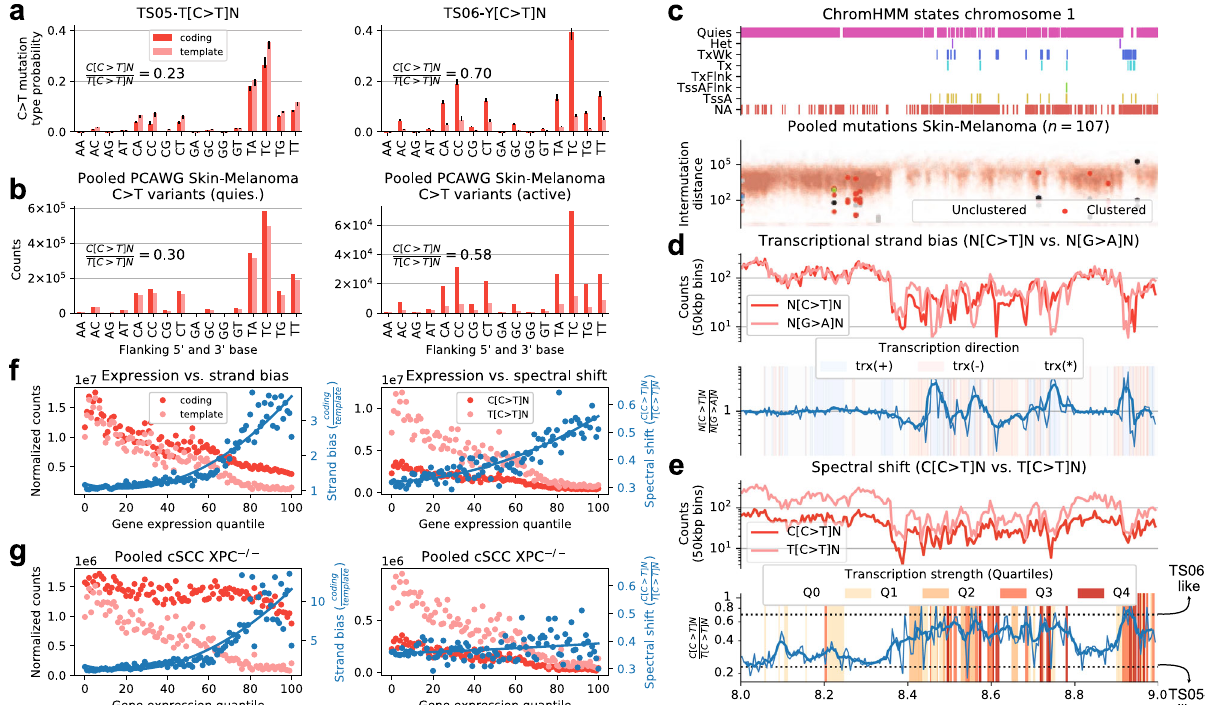
Fig. 4 The spectrum of UV mutagenesis changes from open to closed chromatin. a C > T mutation probabilities of TensorSignatures TS05 and TS06 for coding and template strand DNA (error bars determine 95% bootstrap con fi dence intervals). b Pooled PCAWG Skin-Melanoma C > T variant counts from coding and template strand DNA in epigenetically active (TssA, TssAFlnk, TxFlnk, Tx and TxWk, right) and quiescent regions (Het and Quies, left). c Consensus ChromHMM states from a representative 10 Mbp region on chromosome 1, and the corresponding mutational density of pooled Skin- Melanoma samples. d N[C > T]N and N[G > A]N counts in 50 kbp bins, and their respective ratios (thin blue line: ratio; thick blue line: rolling average over 5 consecutive bins) illustrate the transcriptional strand bias of C > T mutations in quiescent and active regions of the genome. e Relationship between expression strength and the spectral shift of C > T mutations in terms of binned C > T variant counts in TpC and CpC context and their respective ratios (thin blue line) as well as a rolling average (thick blue line). f Gene expression strength vs. transcriptional strand bias (measured by the ratio normalised C > T variants in Skin-Melanoma on coding and template strand), and gene expression strength vs. C[C > T]/T[C > T] spectral shift (indicated as the ratio of normalise C > T mutations in 5'C and 5'T context). g Transcriptional strand bias and C[C > T]/T[C > T] spectral shift in GG-NER de fi cient XPC − / − cSCC genomes. Blue curves: quadratic fi t. Source data are provided as a Source Data fi